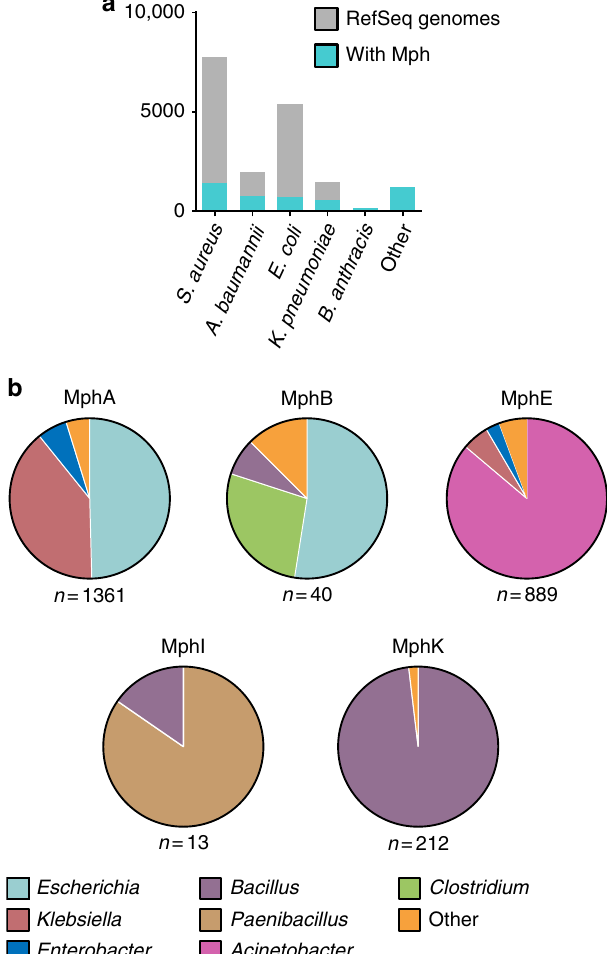
Fig. 3 Taxonomic distribution of Mphs. a The top fi ve bacterial species, in the RefSeq genome database, with Mphs by abundance, and presented in a stacked bar graph. b Taxonomic distribution of MphA, MphB, MphE, MphI, and MphK by